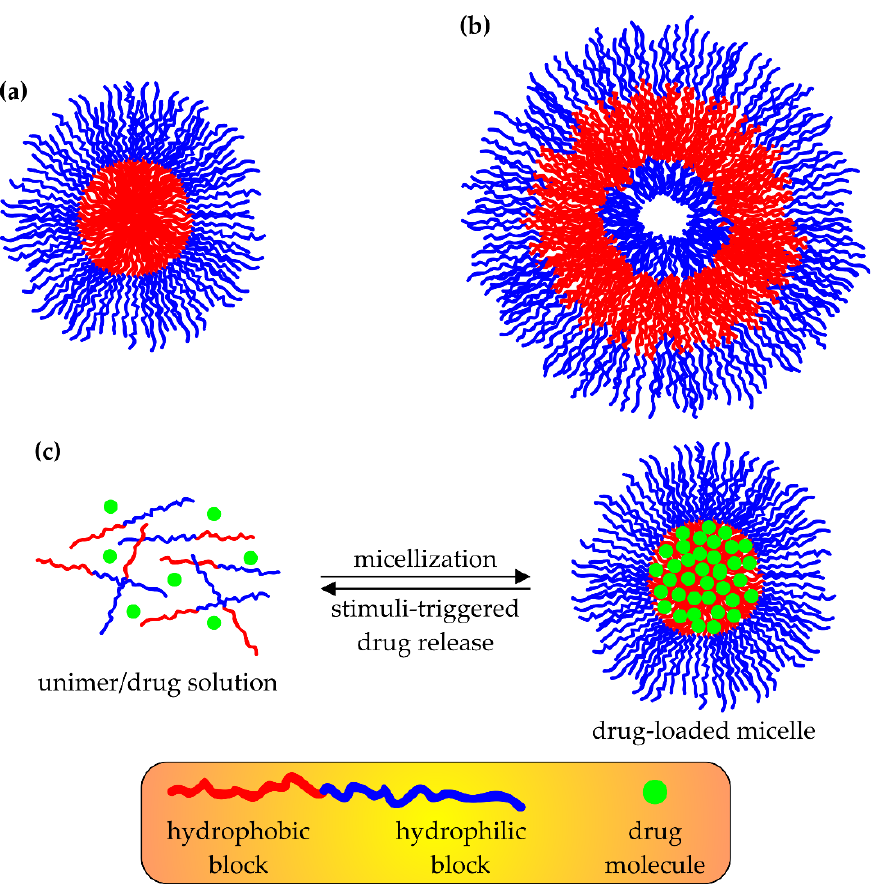
Figure 4. Schematic representations of ( a ) micelle and ( b ) polymersome formed by LBCPs, as well as ( c ) general synthetic strategy applied for the formulation of micelle-based DDSs.